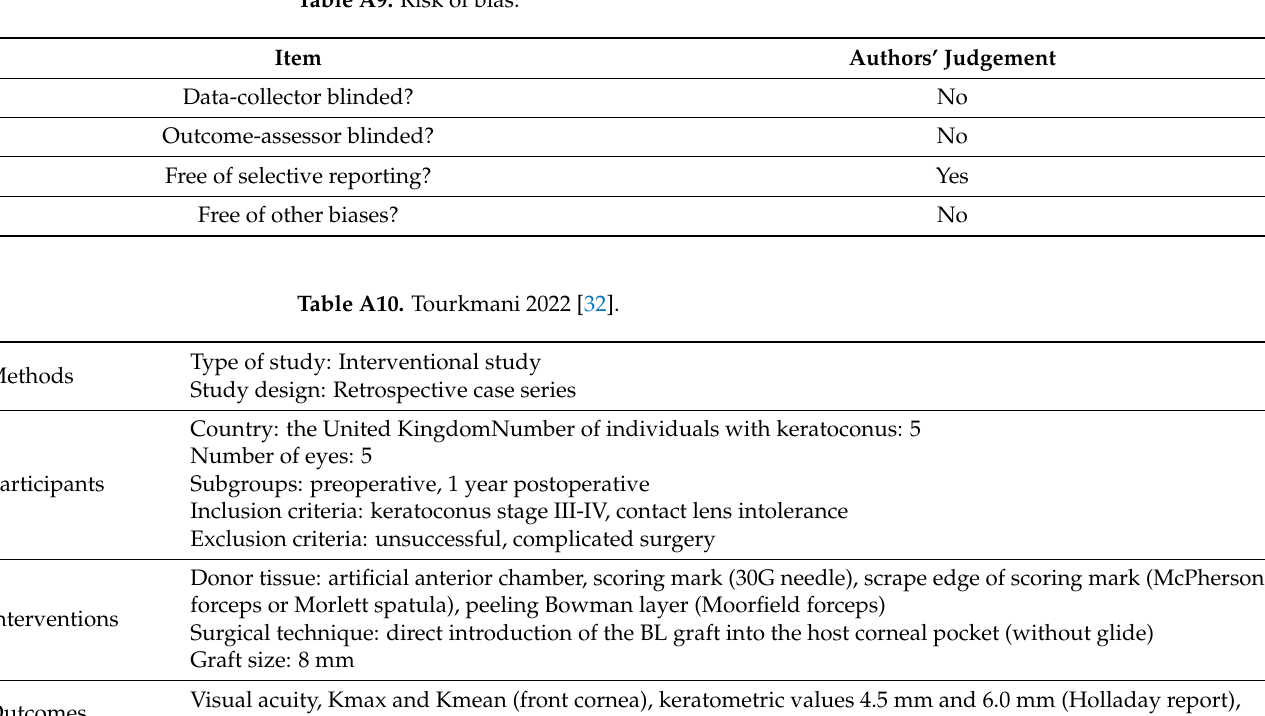
Table A9. Risk of bias.